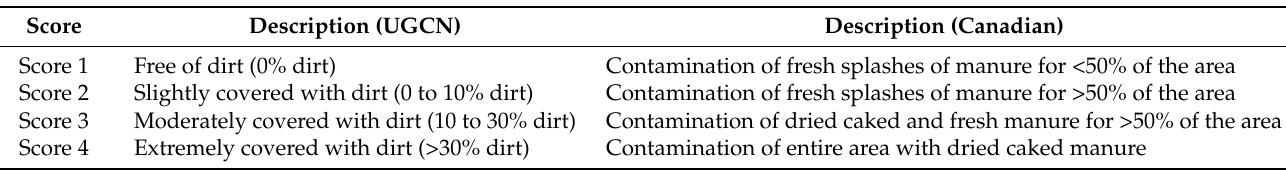
Figure 2. Location of the areas scored using the Dutch Udder Health Centre scheme (UGCN, 2007) and the Canadian Dairy Research Portal for the leg area specifically. Table 2. Description of cow cleanliness score using scales from the Dutch Udder Health Centre scheme (UGCN) and a scale from the Canadian Dairy Research Portal during Experiment 2 .